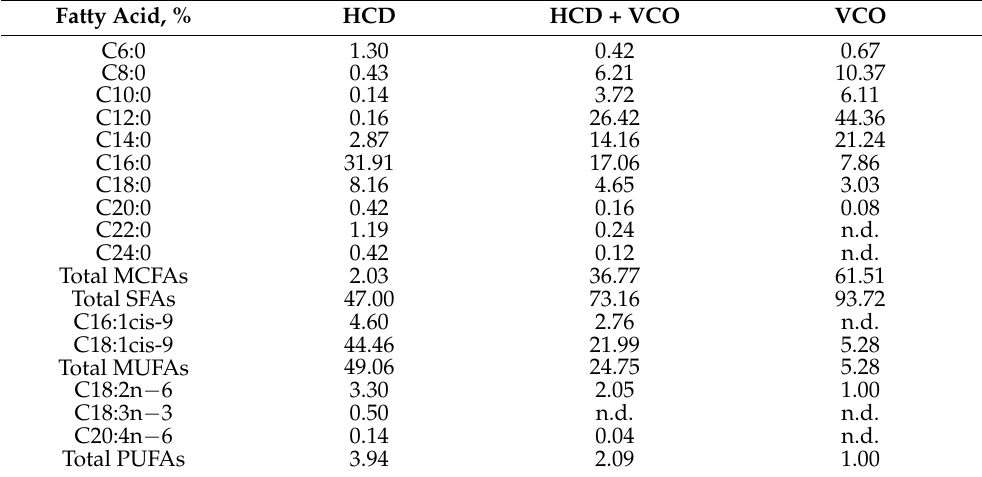
Table 2. Fatty acids composition (% of total fatty acids) of the experimental diets and the virgin coconut oil used in the